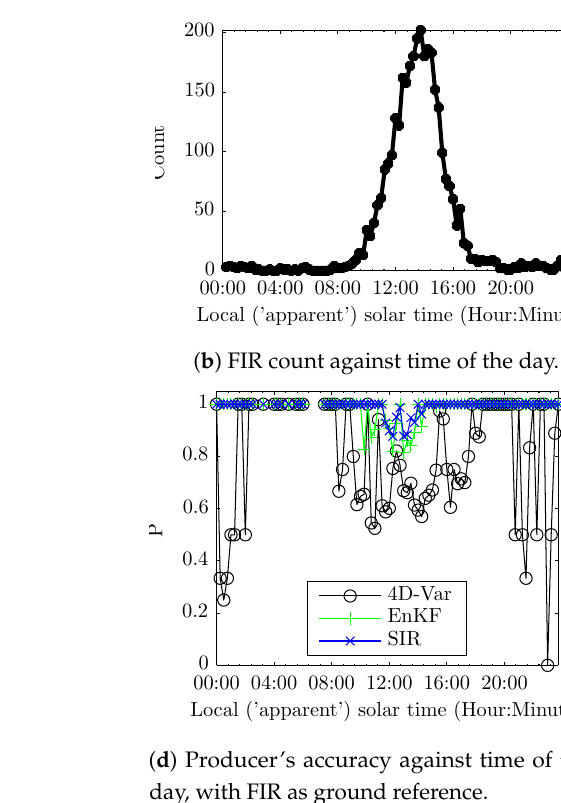
day, with FIR as ground reference. Figure 4. Producer’s accuracy against fire time of the day (96 samples) over five days. The empirical distribution of MSG IR 3.9 brightness temperatures